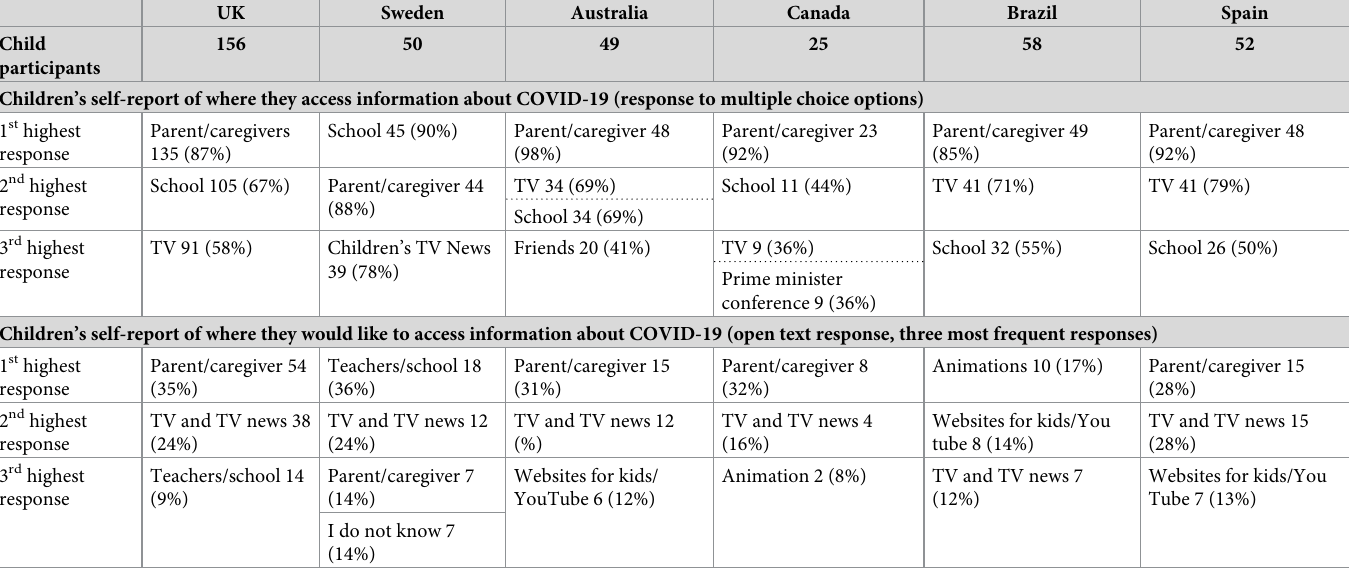
Table 4. Children’s self-report of their access to information about COVID-19.